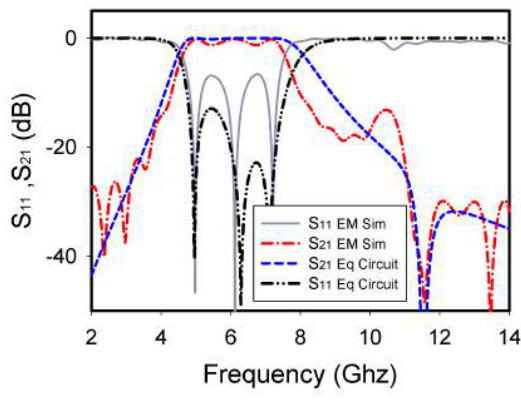
Figure 8: Insertion loss of the proposed C-band bandpass filters with Slot and 2 (cid:0) CSRRs